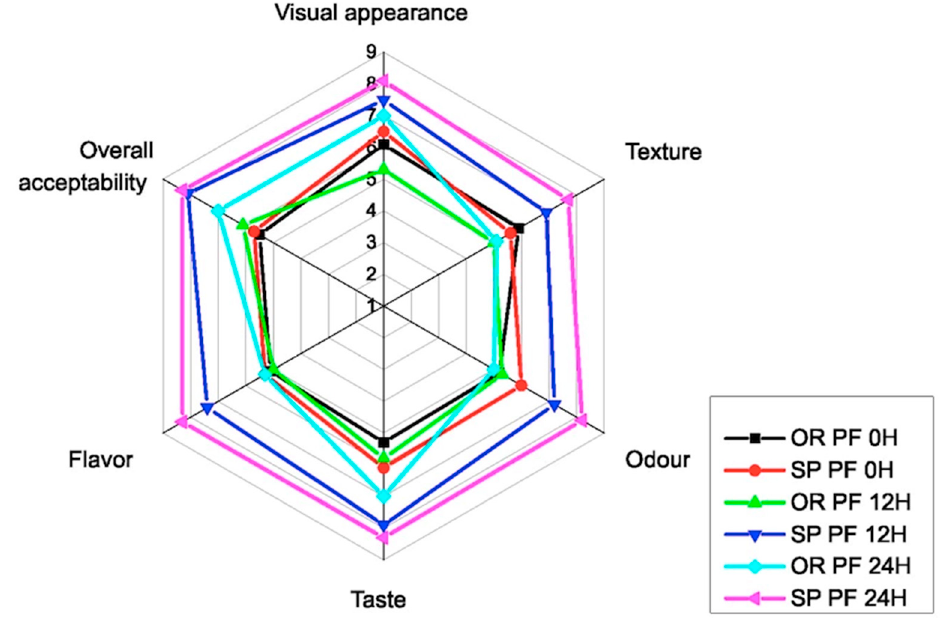
Figure 3. Hedonic scores for of GFM (gluten free muffins) obtained with inoculated (SP) and non-inoculated (OR) sourdoughs at different fermentation time: 0, 12, 24 h.